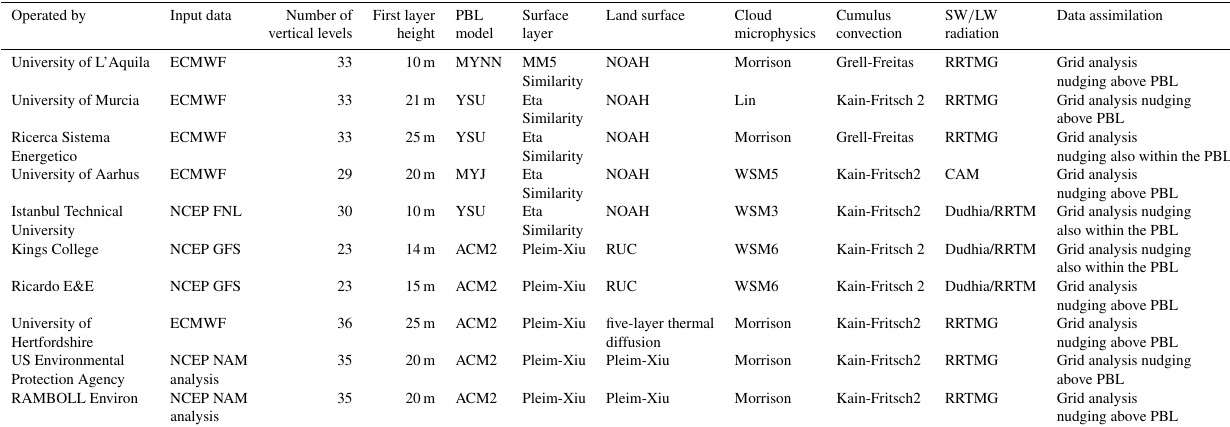
Table 2. Configuration of the WRF model by modeling group. Operated